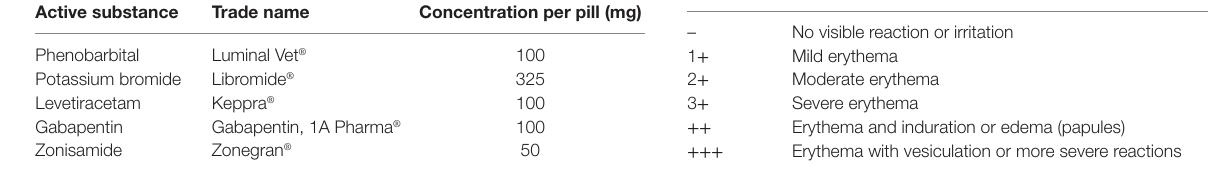
TaBle 3 | evaluation of patch test